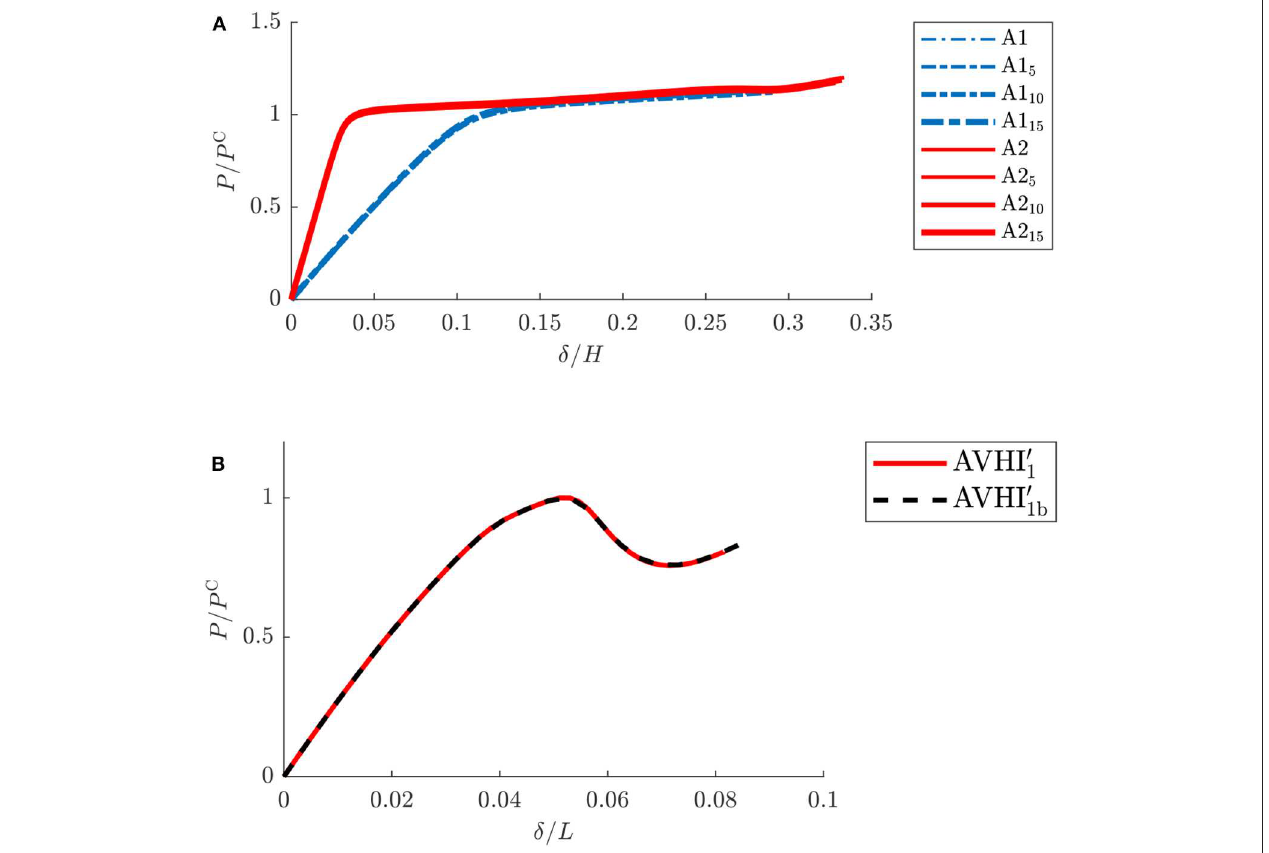
FIGURE 13 | Normalized load vs. normalized end-shortening behavior for unit cells and sandwich panels. (A) P / P C vs. δ/ H comparisons of the shallower cell types A1 and A2 with scaled variations A1 5 , A1 10 , A1 15 , A2 5 , A2 10 , and A2 15 which are scaled by factors of 5, 10, and 15. (B) P / P C vs. δ/ L for panel types AVHI ′ 1 and AVHI ′ 1b (a scaled variation of AVHI ′ 1 by a factor of